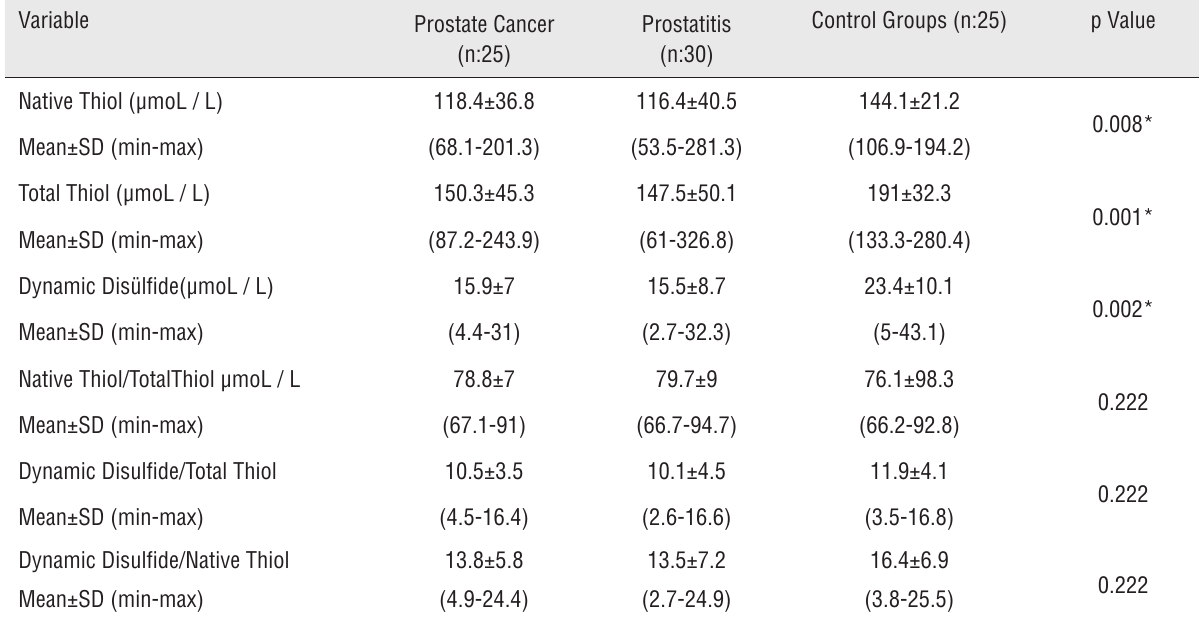
Table 2 - Differences between groups.